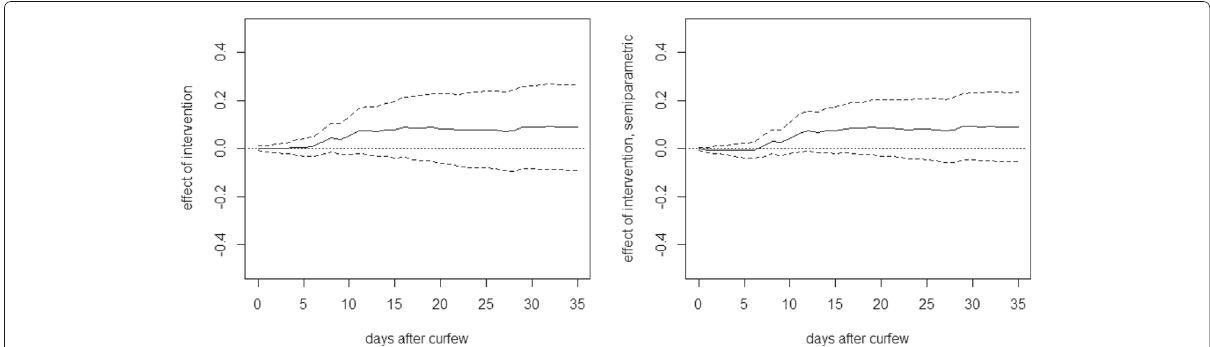
Fig. 6 OLS (left) and DR (right) effects of curfews on deaths per 10,000 inhabitants in Germany